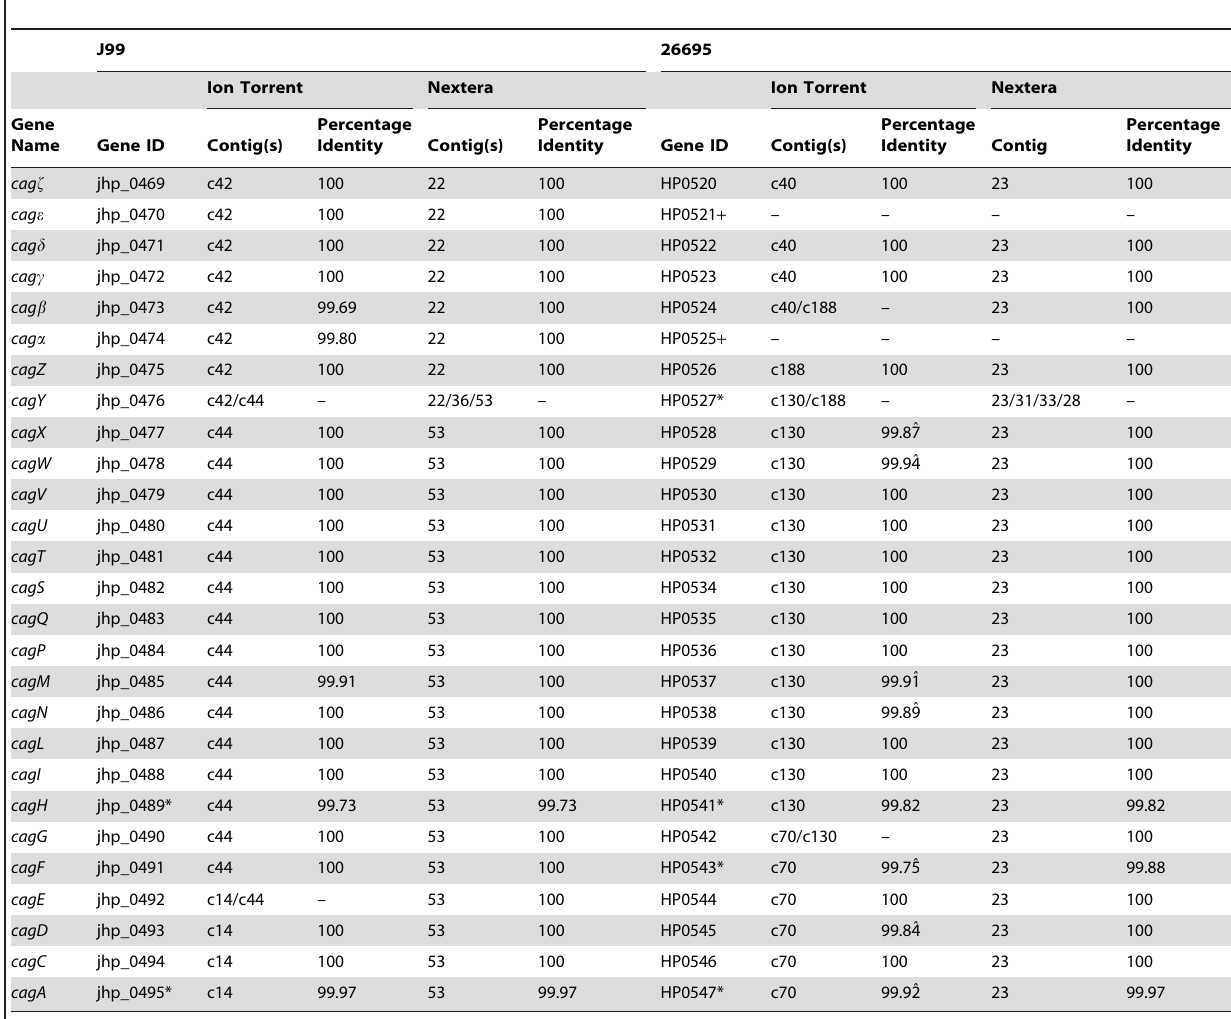
Table 6. Analysis of the accuracy of the assembled cagPAI coding